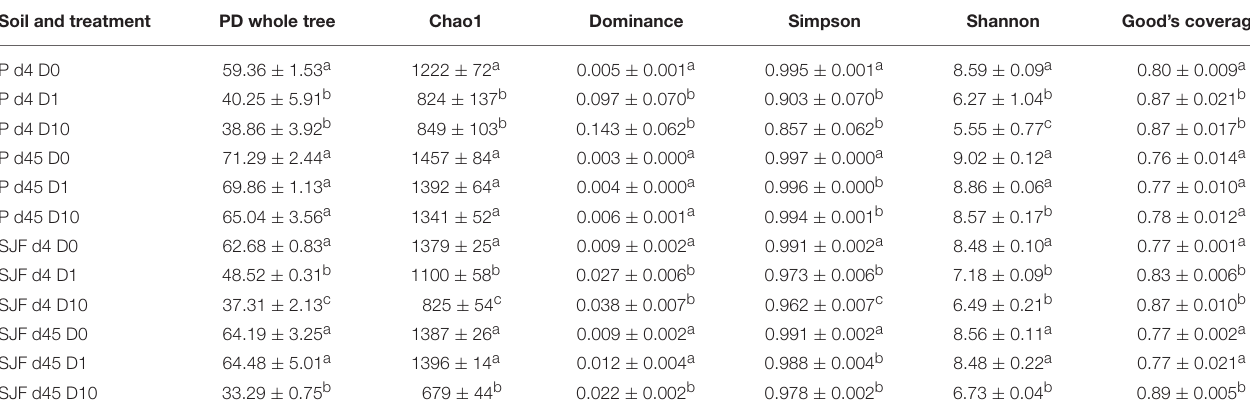
TABLE 1 | Richness and diversity indices of the bacterial community were calculated for P and SJF soil microcosms exposed to leptospermone applied at different concentrations (D0, D1, and D10) at 4 and 45 days. Soil and treatment PD whole tree Chao1 Dominance